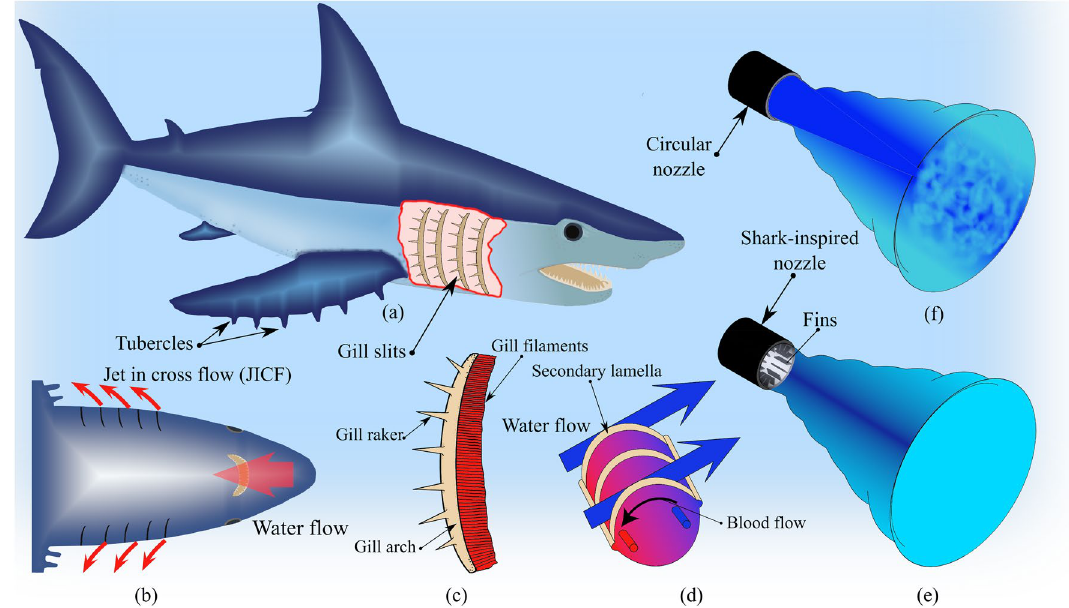
Figure 1. Modelling of bio-inspired nozzle. ( a ) shark anatomy, ( b ) ram ventilation concept corresponding to jet in cross flow, ( c ) drawing of a gill showing gill filaments (oxygen absorption), gill arch (supporting structure), and gill rakers, ( d ) schematic drawing of a portion of filaments and their secondary lamellae and also the countercurrent exchange system, ( e ) schematic drawing of shark-inspired nozzle, and ( f ) circular jet